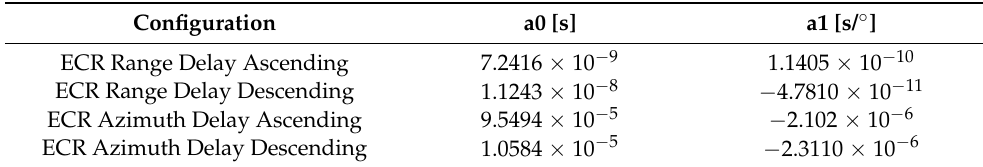
Figure 2. ECR offsets for the different pass geometries observed with the ECR network (colors indicate individual stations). Average offsets estimated with least-squares adjustment from residuals of surveyed ECR positions and measured SAR data filtered for outliers. Range offset estimates per geometry ( left ) and azimuth offset estimates per geometry ( right ). Black bars show the 95% confidence intervals of the estimation results. Red lines show the angular-dependent ECR delay models, as listed in Table 3. Table 3. ECR range and azimuth time delay model coefficients for ascending and descending measurements as derived from ECR residuals of the installation sites DLR2, Mårtsbo, Vinberget, Vergi and Loksa, see Figure 2. The a 0 denotes the mean offset and the a 1 denotes the linear component that depends on the incidence angle of the Sentinel-1 swath, i.e., 20 to 45